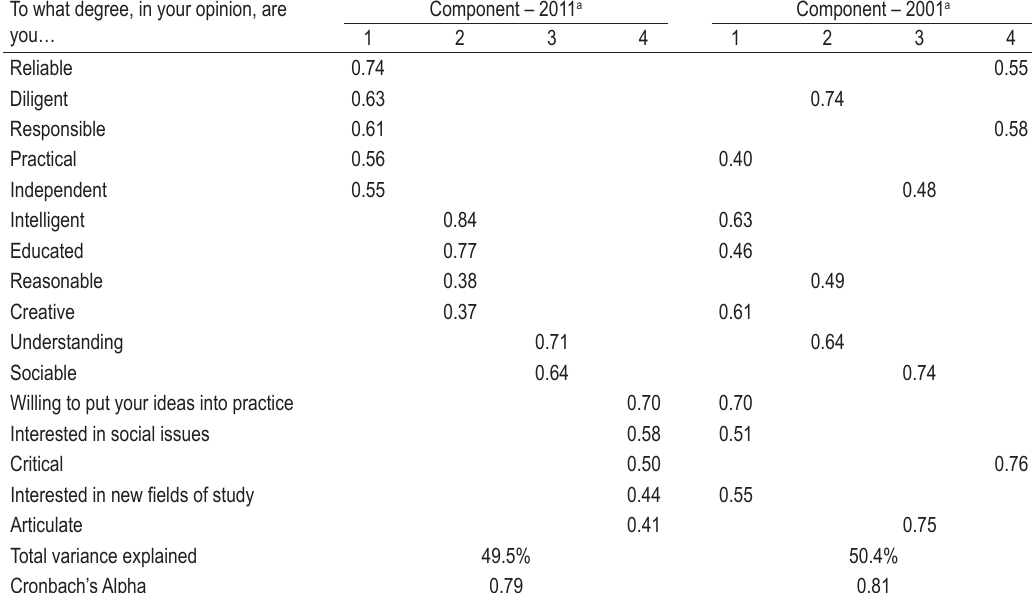
Table 3. Rotated component